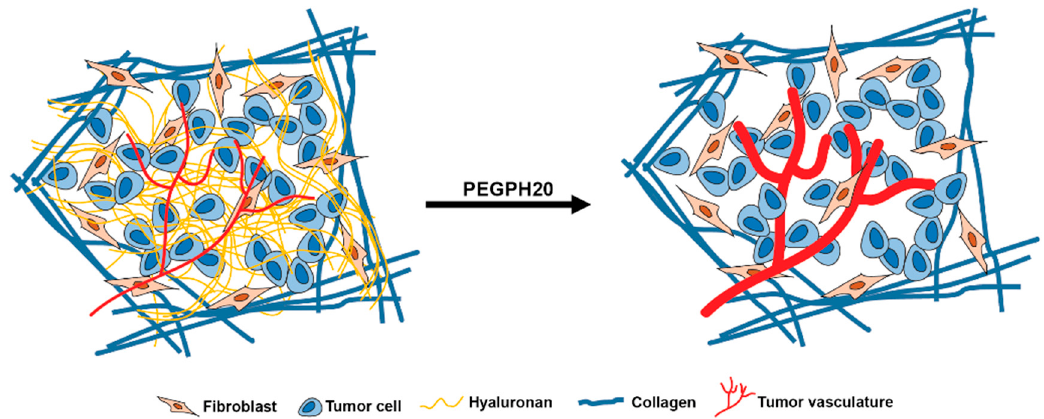
Figure 1. Depletion of hyaluronan with PEGylated recombinant human hyaluronidase (PEGPH20) alters the biophysics of pancreatic ductal adenocarcinoma (PDA). The inordinately high intratumoral gel–fluid pressures in PDA create a physical barrier to diffusion and convection. Targeting hyaluronan in the tumor stroma with PEGPH20 removes this barrier and increases perfusion along with associated changes in quantitative magnetic resonance imaging (MRI) measurements, decreased glycosaminoglycan-spectrum chemical exchange saturation transfer (GagCEST), decreased T2-weighted signal intensity, and an increase in low-b apparent diffusion coefficient (ADC).